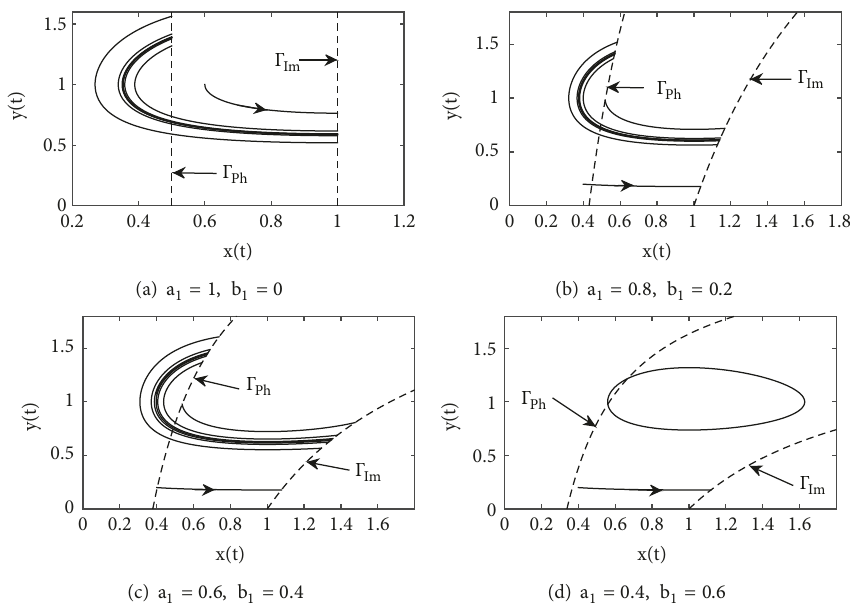
Figure 4: The existence and stability of order-1 periodic solution of system (1) with 𝑎 = 1,𝑏 = 1,𝑐 = 0.3,𝑑 = 0.3, 𝐴 = 1,𝑝 = 0.5, 𝜏 = 0.8 and different weighted parameters 𝑎 1 and 𝑏 1